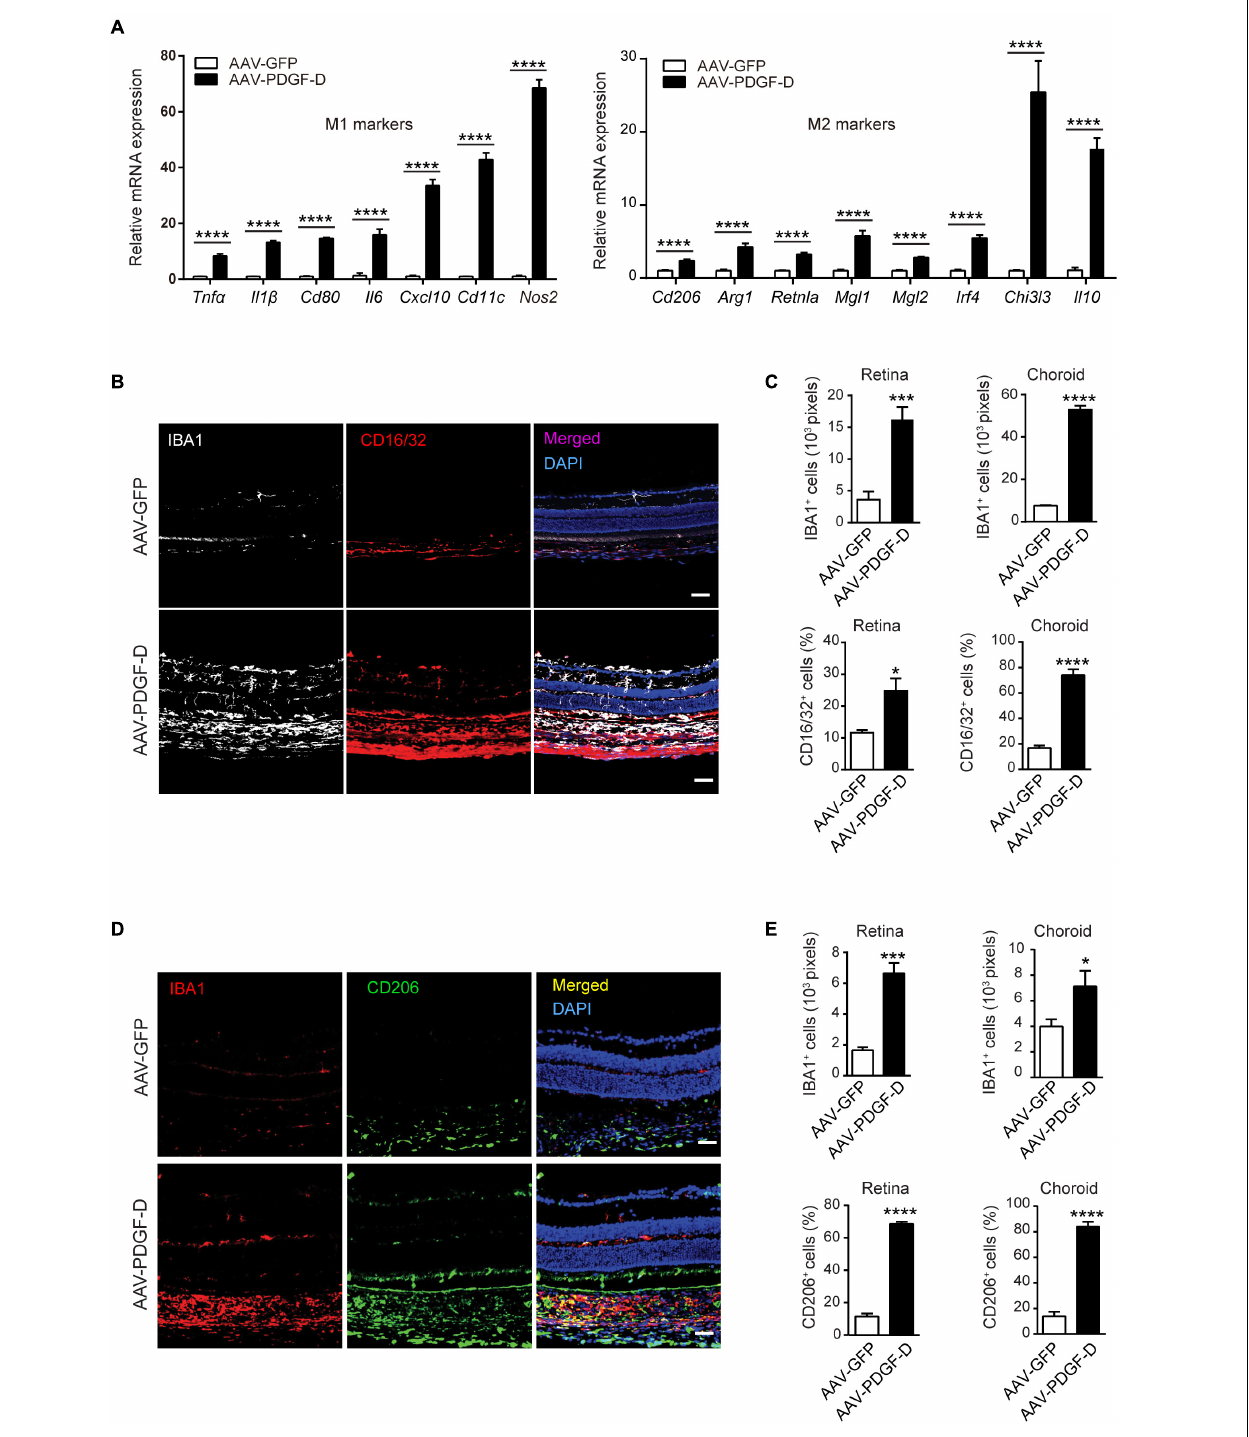
FIGURE 4 | PDGF-D induced macrophage polarizations. (A) Real-time PCR analysis of markers of M1 and M2 macrophage polarization regulated by PDGF-D in mouse retinal pigment epithelium. (B) Immunofluorescence staining for IBA1 + and CD16/32 + (M1 marker) cells in mouse retinae and choroids with AAV-GFP or AAV-PDGF-D injection. (C) Quantifications of IBA1 + and CD16/32 + macrophage densities in (B) . (D) Immunofluorescence staining of IBA1 + and CD206 + (M2 marker) cells in mouse retinae and choroids with AAV-GFP or AAV-PDGF-D injection. (E) Quantification of CD206 + macrophage cell density in retinae and choroids in (D) . Scale bar: 50 µ m. n = 5, * p < 0.05, *** p < 0.001, **** p < 0.0001.